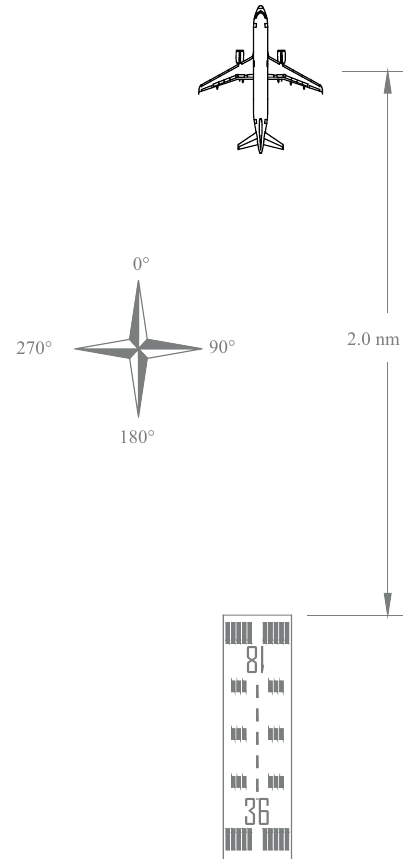
Fig. 1. Aircraft location at the beginning of the engines-out emergency landing (not drawn to